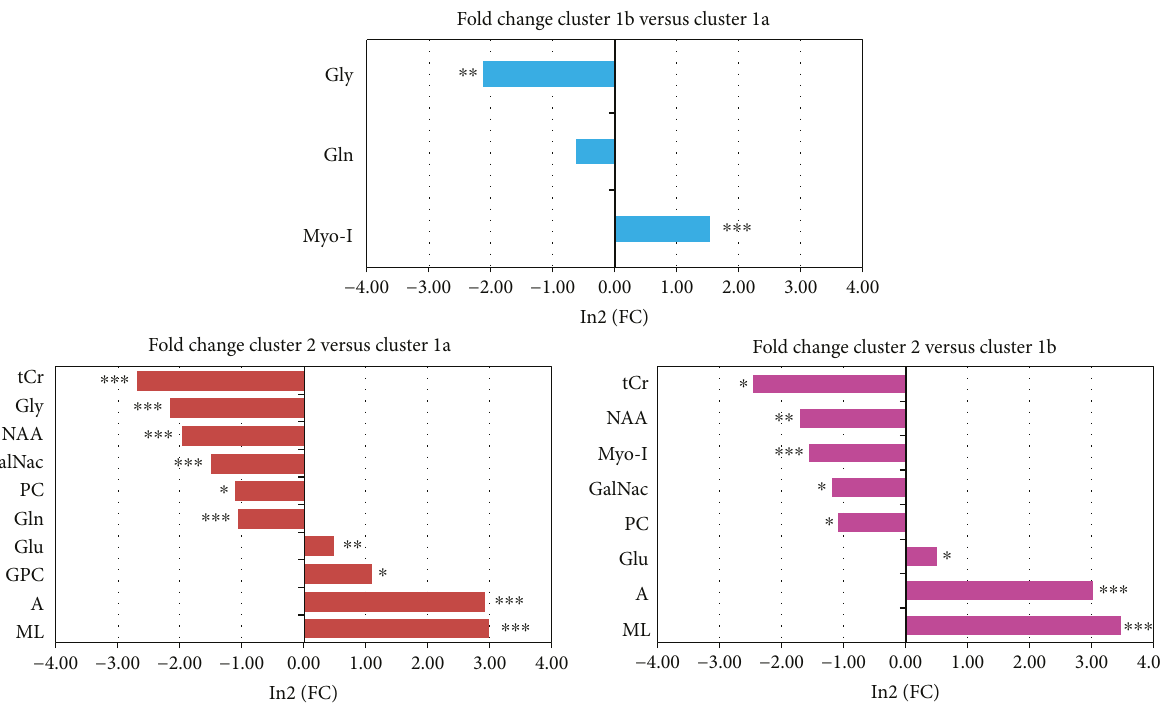
Figure 2: Statistics of metabolic clustering. (a) Box-and-whisker plots of metabolite signal intensities measured in MR spectra from GSC lines belonging to cluster 1a (blue), 1b (brown), and 2 (pink). Intensities of NAA, GABA, Gln, A, Myo-I, Asp, Glu, GSH, PC, and GPC were quanti fi ed in 2D COSY spectra and GalNAc, UDP, Gly, ML, and tCr in 1D spectra. (b) log2(FC) ((FC) fold change) of metabolite signal intensities of cluster 1b with respect to cluster 1a, of cluster 2 with respect to cluster 1a, and of cluster 2 with respect to cluster 1b. Only signi fi cant changes are reported with ∗ p < 0 05 , ∗∗ p < 0 005 , and ∗∗∗ p < 0 0005